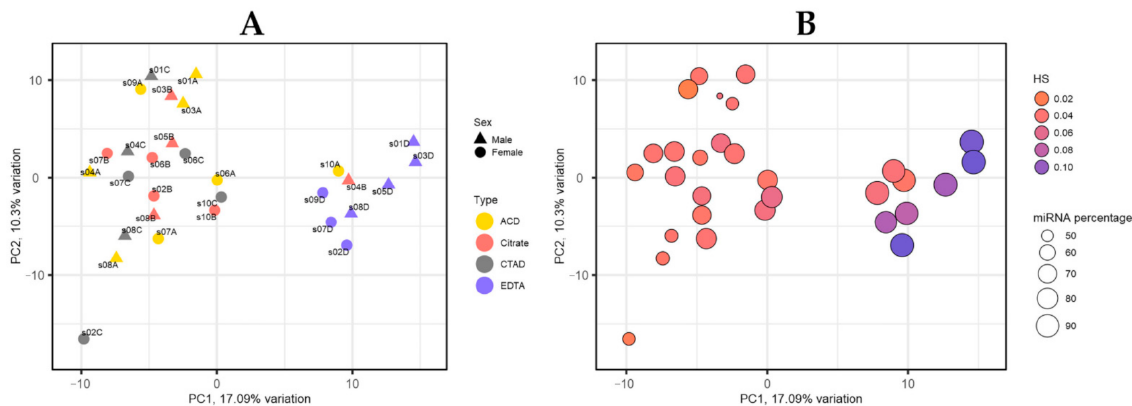
Figure 6. Principal component analysis of miRNA profiles by the PCAtools R package, version 2.2.0. ( A ) PC1-PC2 plot showing the ID and sex of participants and study groups based on the anticoagulant type. ( B ) PC1-PC2 plot showing hemolysis score (HS) values and percentage of miRNA